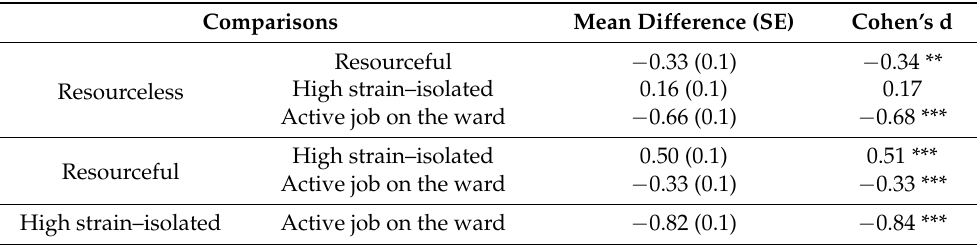
Table 6. Paired comparisons between latent profiles in job